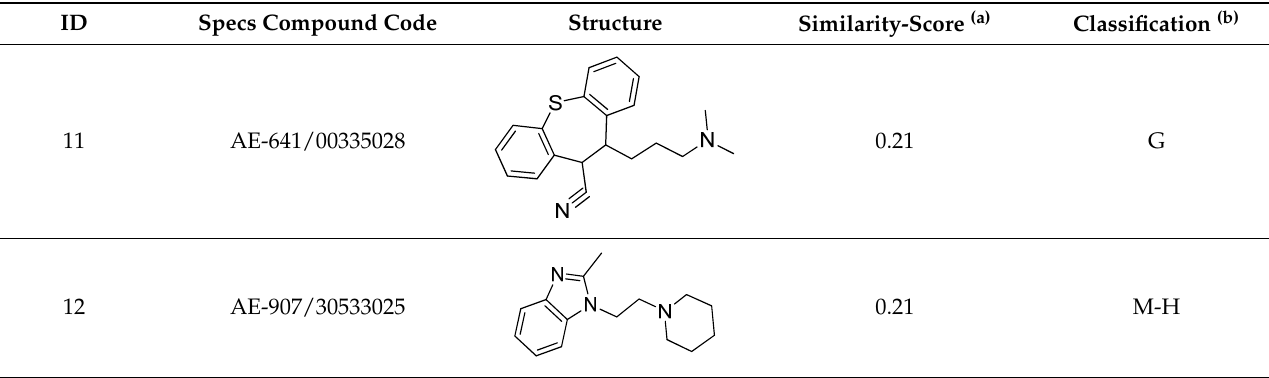
Table 3. List of 10 substrate candidates for the proton-antiporter, based on virtual screening results using the P2 pharmacophore as a template and classified by their substrate potency in hCMEC/D3 cells.